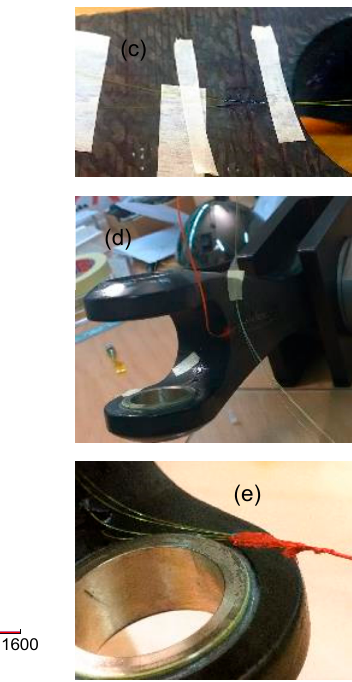
Figure 6. ( a ) Scheme of layout of FBG arrays Y-array and C-array; ( b ) Y-array and C-array spectra; and ( c ), ( d ) and ( e ) pictures during the gluing of sensors.